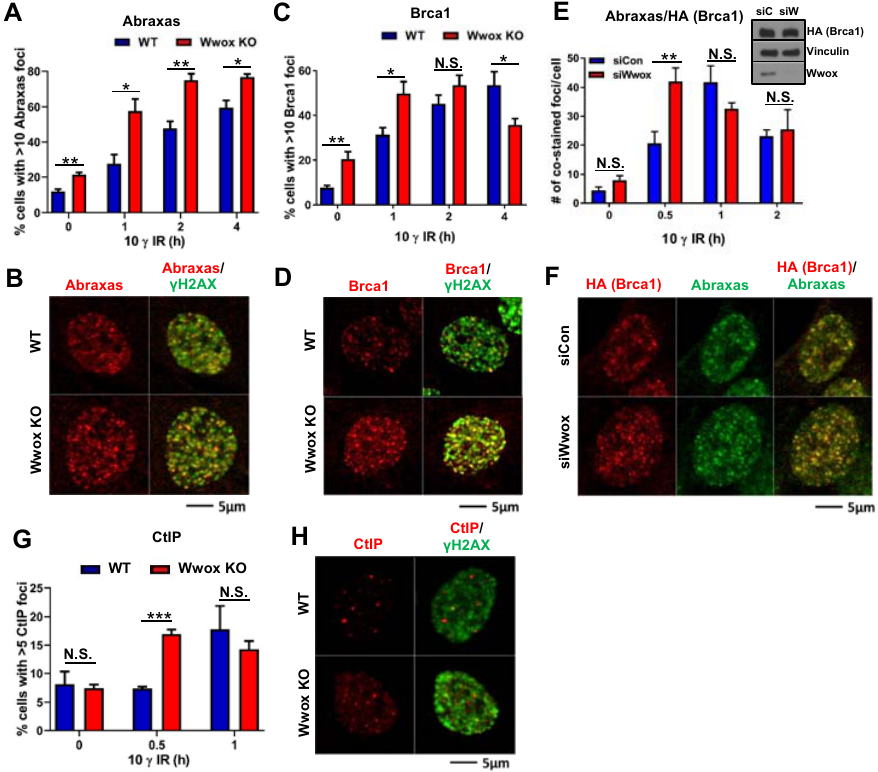
Figure 3. Timing of Abraxas, Brca1, CtIP of appearance in IR-induced foci in mouse MEFs ( A – D ) IR ‐ induced focus formation of Abraxas ( A , B ) and Brca1 ( C , D ) was measured in WT and Wwox KO MEFs. Cells were irradiated (10 γ ) and fixed at the indicated times. Wwox KO cells showed significantly more Abraxas foci positive cells at each time ‐ point. An increase of Brca1 foci positive cells was observed in Wwox KO cells at 0 and 1 h post ‐ IR, and no significant difference in WT vs. Wwox KO at 2 h post ‐ IR. The number of Brca1 positive cells in Wwox KO cells was decreased at 4 h post ‐ IR; representative images of Abraxas (red), Brca1 (red) and γ H2AX (green) were from 1 h time ‐ point ( B , D ). ( E , F ) Time ‐ course study of colocalization of Abraxas with Brca1 foci in MEFs expressing Flag ‐ HA tagged wild type Brca1 protein. Transient silencing of Wwox increased the co ‐ stained number of foci at 0.5 h post ‐ IR. Wwox silencing was confirmed by immunoblot (siC: siControl and siW: siWwox); representative images showing expression of Abraxas (green) and HA ‐ Brca1 (red) were from 0.5 h post ‐ IR ( F ). ( G , H ) CtIP foci formation is increased in Wwox KO cells at early time ‐ point (0.5 h post ‐ IR), but no significant difference was observed at 1 h post ‐ IR. Error bars representing S.E.M and p ‐ values were calculated by unpaired t ‐ test (* p < 0.05, ** p < 0.01, *** p < 0.001); N.S., not significant. Experiments were carried out using two different wild ‐ type (WT3, WT4) and KO (KO3, KO5) clones in duplicate.